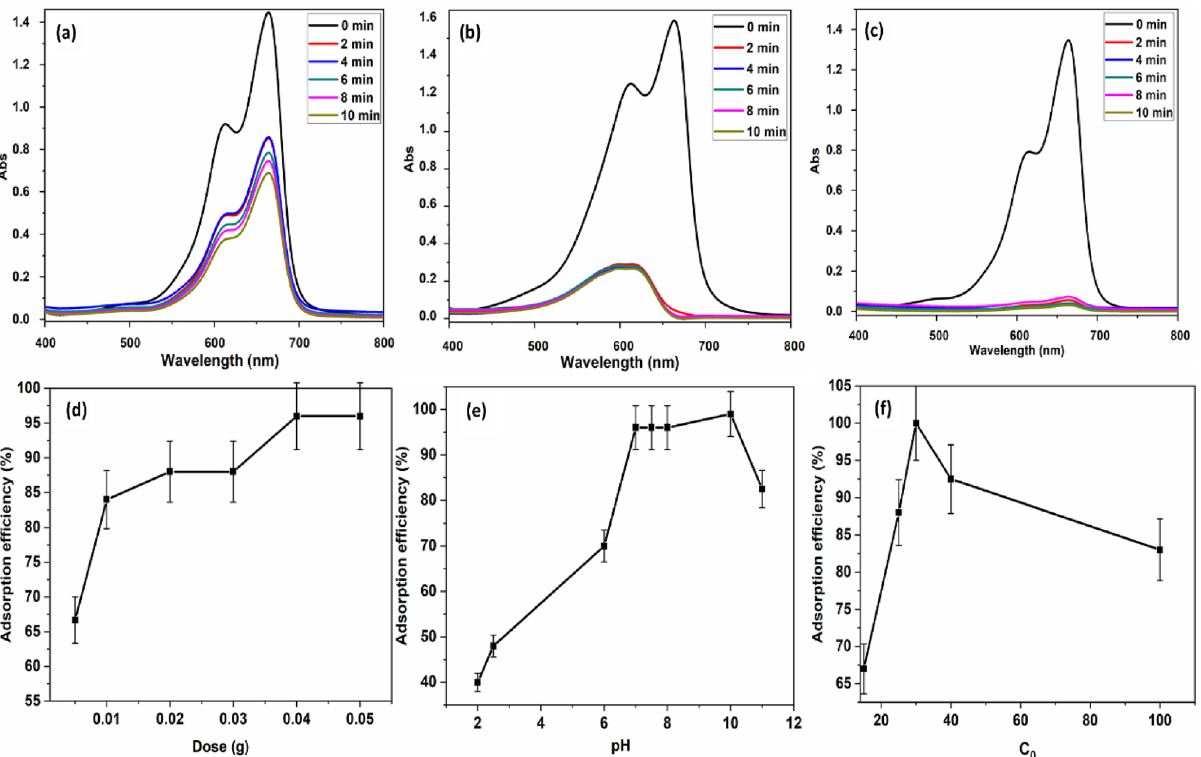
Figure 7. ( a , b , c ) Show UV–Vis spectra of 20 ppm MB solution before and after mixing with 40 mg PAK in conjunction with pH change ( a ) pH 2.5, ( b ) pH 7.5, ( c ) pH 10 . ( d , e , f ) Show the relation between adsorption efficiency % and ( d ) dose of polymer, ( e ) pH change, and ( f ) initial dye concentration of